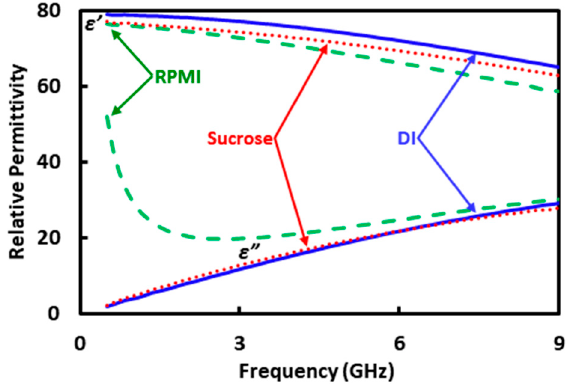
Figure 4. Real and imaginary parts of measured permittivities, ε ’ and ε ” , of DI ( ‒‒ ), sucrose ( · · · ), and RPMI ( - - - ) solutions.